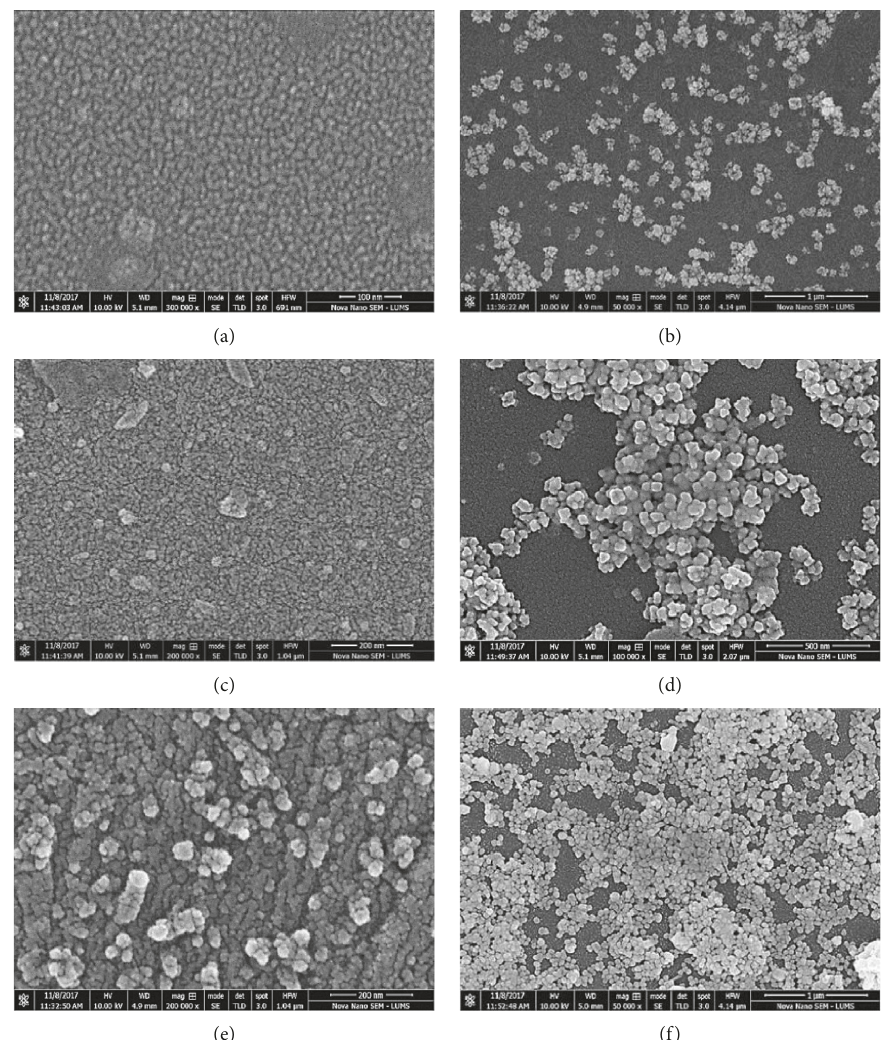
Figure 7: SEM micrographs of TiO 2 thin films having different thickness: (a) 37.54nm, (c) 51.92nm, and (e) 99.55nm, without (left) and with AgNPs